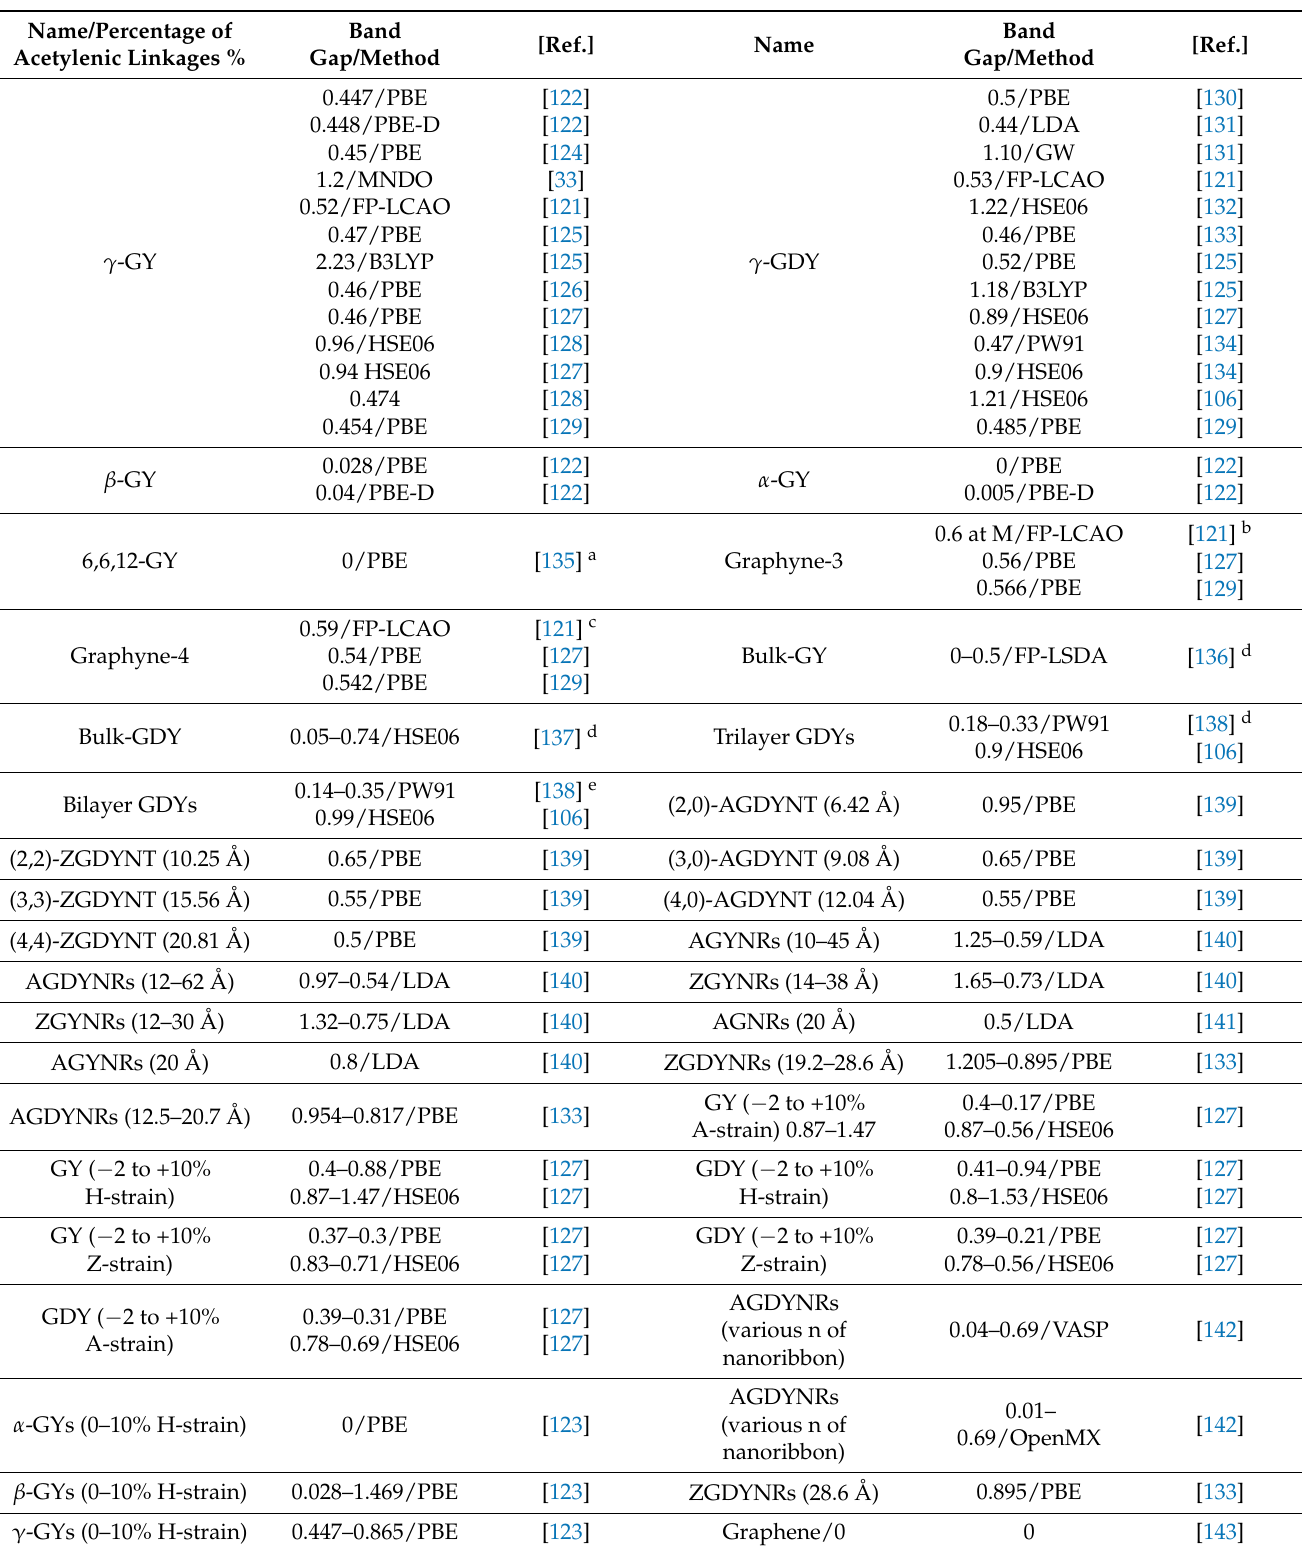
Table 2. Calculated band gaps of GYs based on different summarized